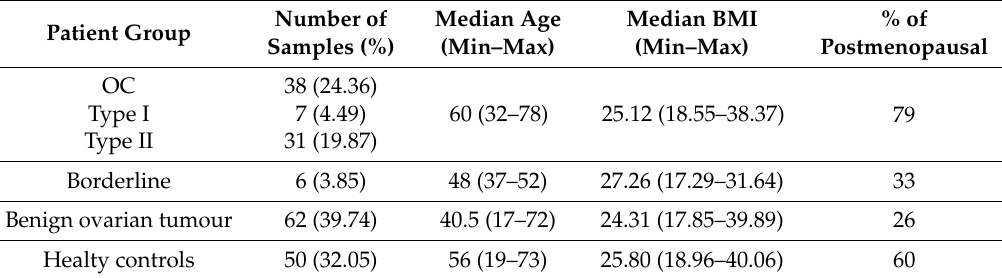
Table 5. Characteristics of OC (ovarian cancer) group.